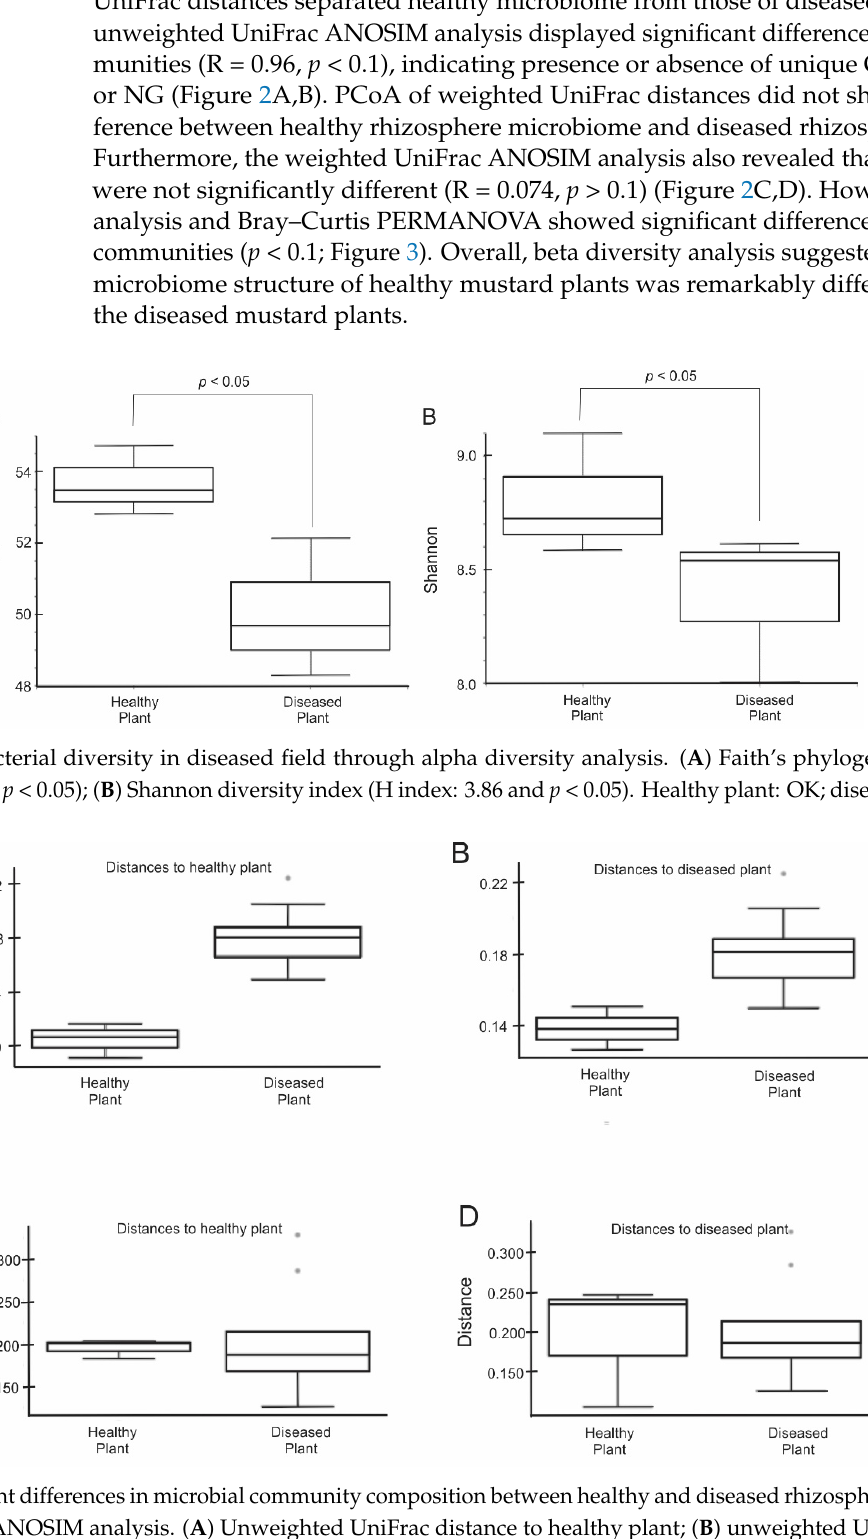
Figure 3. Significant differences in microbial community composition between healthy and dis- eased rhizosphere microbiome through Jaccard and Bray–Curtis PERMANOVA. ( A ) Jaccard dis- tance to healthy plant (OK); ( B ) Jaccard distance to diseased plant (NG); ( C ) Bray–Curtis distance to healthy plant (OK); ( D ) Bray–Curtis distance to diseased plant (NG).